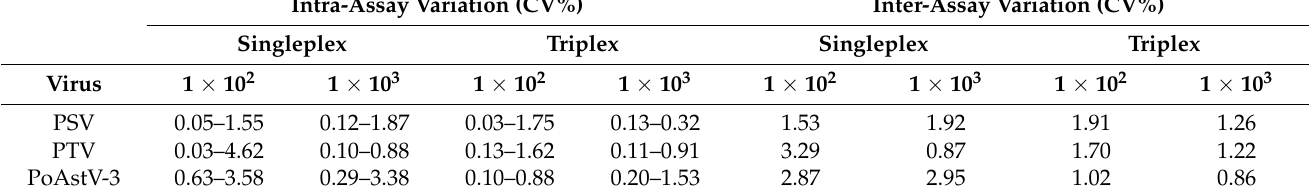
Table 3. Summary of the results of intra/inter assay coefficients of variation (CV%). PSV: porcine sapelovirus, PTV: porcine teschovirus, PoAstV-3: porcine astrovirus type 3. 1 × 10 2 , 1 × 10 3 :